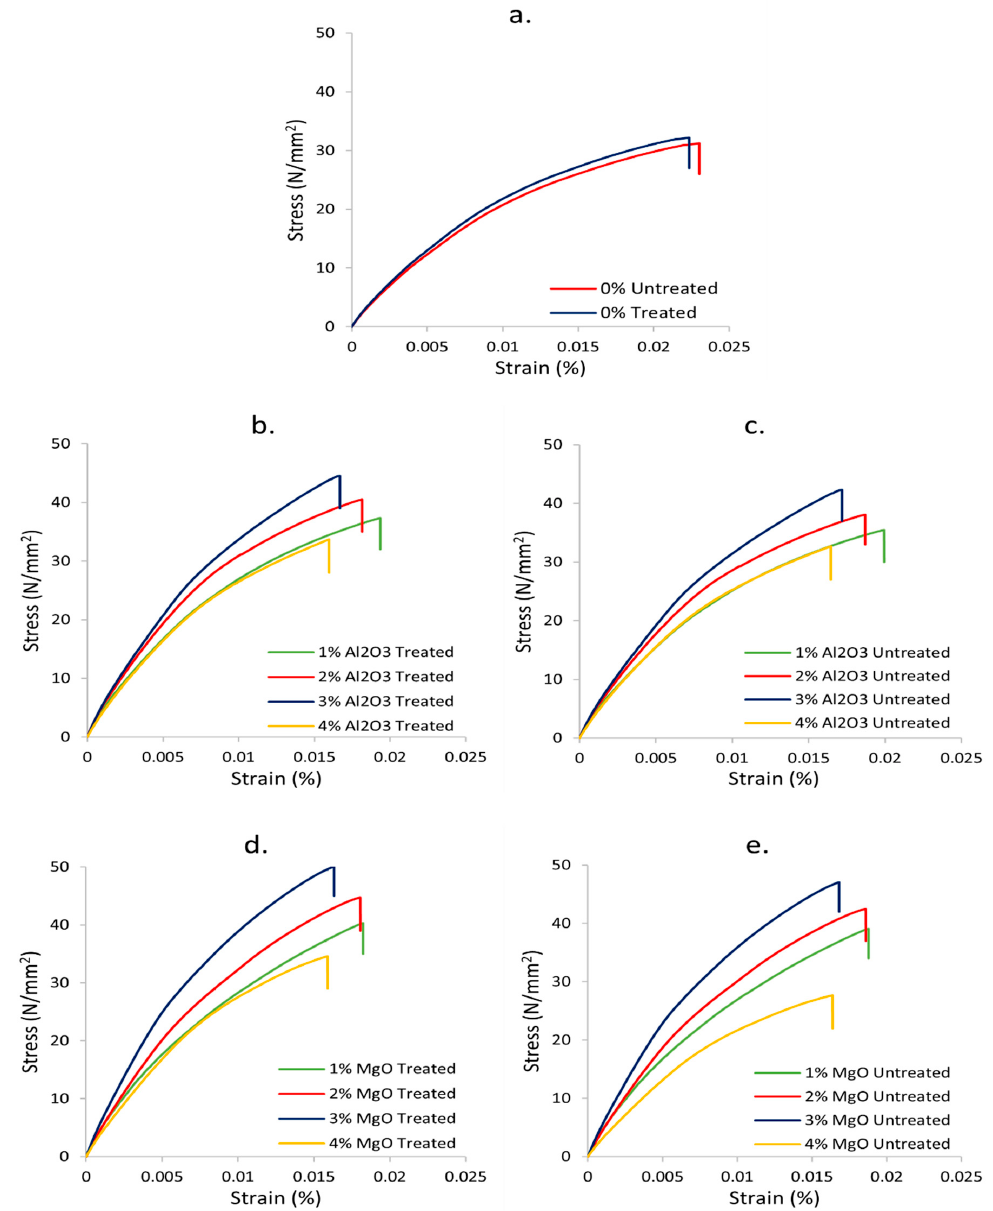
Figure 2. Tensile stress–strain curves of ( a ) neat composite, ( b ) Al 2 O 3 —treated, ( c ) Al 2 O 3 —untreated, ( d ) MgO—treated, and ( e ) MgO—untreated flax/PLA epoxy hybrid composites.